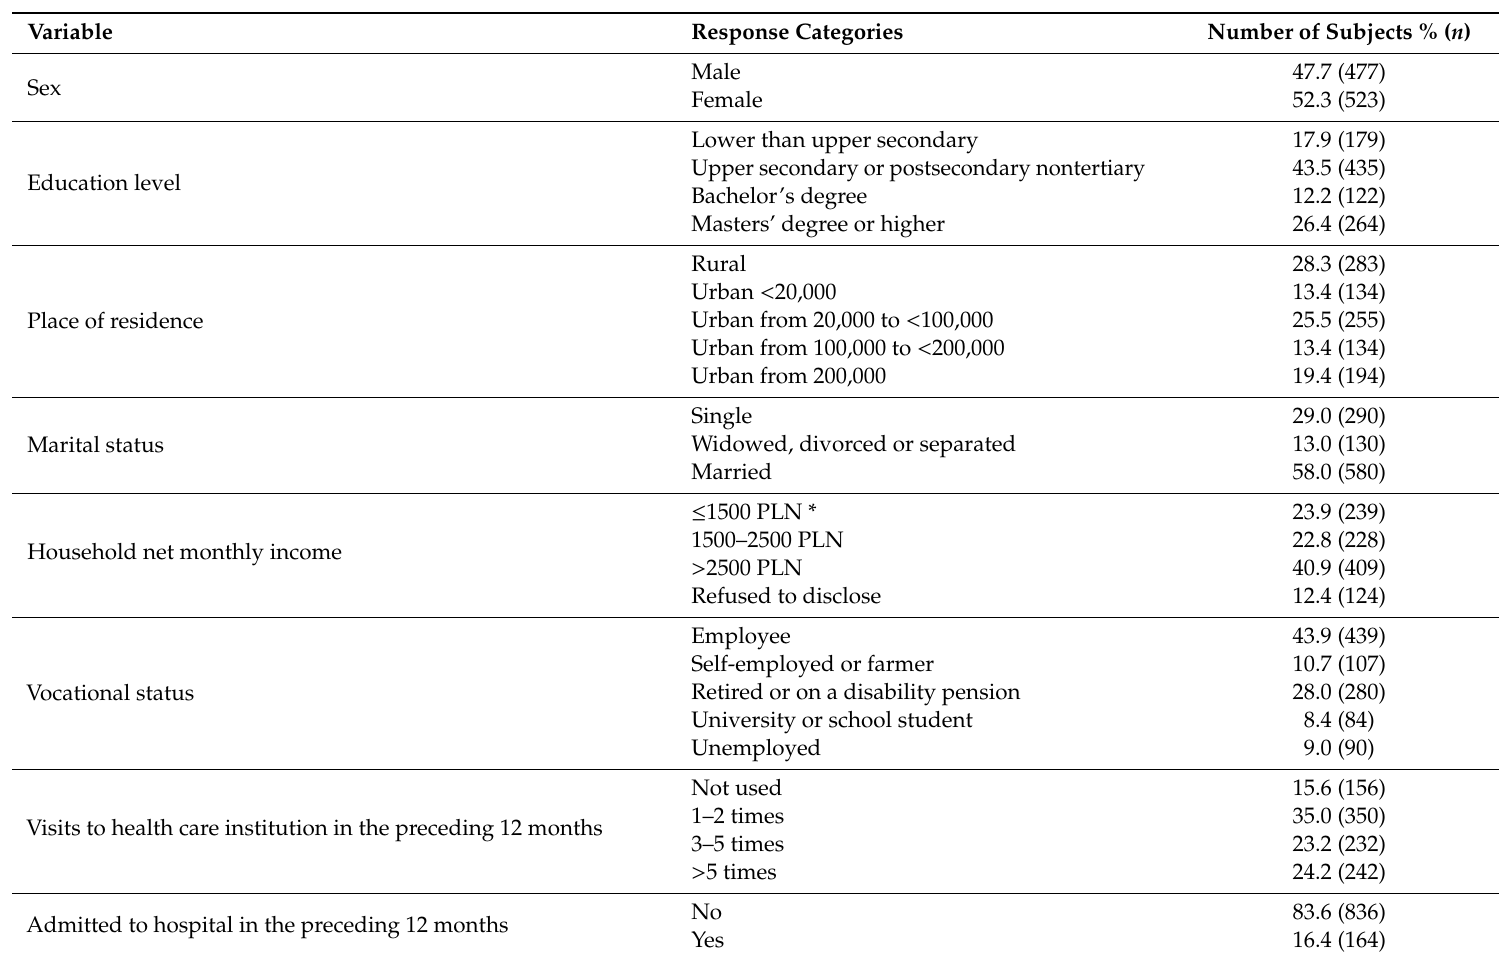
Table 1. Characteristics of the study